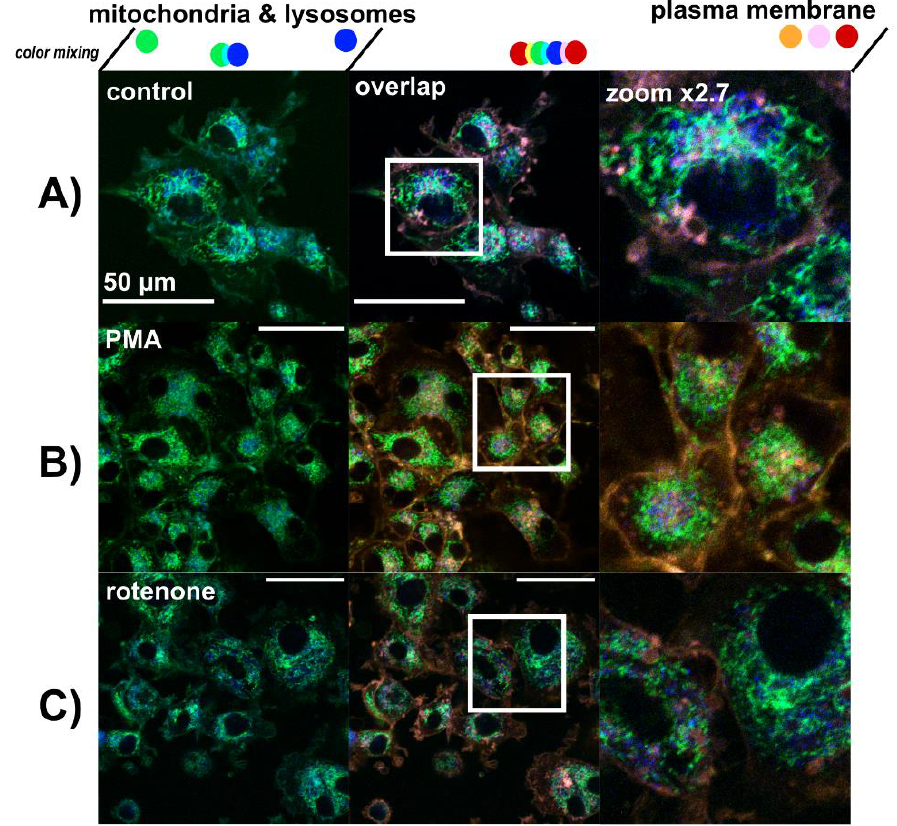
Figure 4. Confocal fluorescence images of rhodamine 123—mitochondria (green), LysoTracker Blue—lysosomes (blue), and Cell Mask Orange—plasma membrane (orange and red) in ( A ) U87 MG cells without treatment, ( B ) treated with 1 µ M PMA, and ( C ) 10 µ M rotenone for 5 h. The overlapping images were magnified to better see the organelles detected. Scale bar—50 µm.